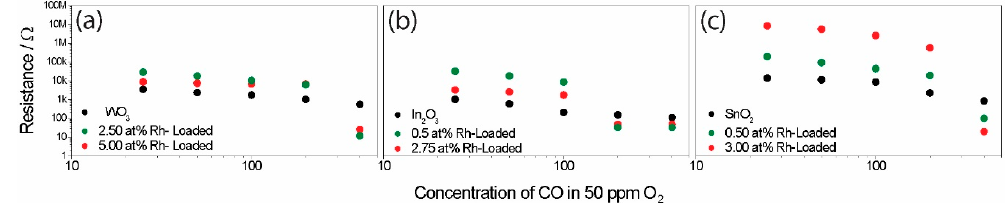
Figure 7. The change in resistance of the sensors, based on WO 3 ( a ), In 2 O 3 ( b ), and SnO 2 ( c ), during exposure to different CO concentrations in a low-oxygen background, measured during the simultaneously measured diffuse reflectance infrared Fourier transform (DRIFT) spectroscopy, is plotted in